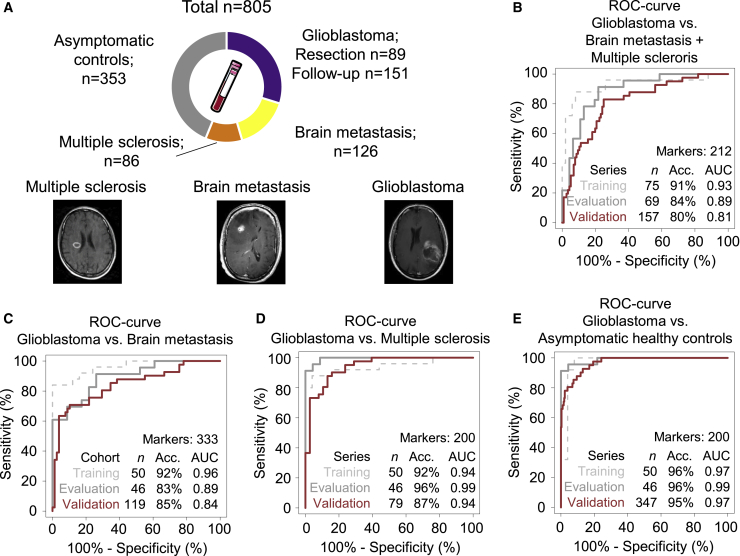
TEP RNA Profiling for Brain Tumor Diagnostics(A) Schematic overview of TEPs as biosource for liquid biopsies and number of groups and sample series sizes included.(B and C) receiver operating characteristics (ROC) curves of (B) “glioblastoma versus brain metastasis plus multiple sclerosis” algorithm, (C) “glioblastoma versus brain metastasis” algorithm, (D) “glioblastoma versus multiple sclerosis” algorithm, and (E) “glioblastoma versus asymptomatic healthy controls” algorithm, including the training series (dashed gray), evaluation series (gray), and validation series (red). Indicated are sample series sizes, best accuracy, and AUC value. Sample HC0068 and sample Maas-GBM-NICT-035G were inadvertently duplicated in the training or validation series because of a randomization code error identified after the validation process.See also Figure S1 and Tables S1 and S2A–S2E.